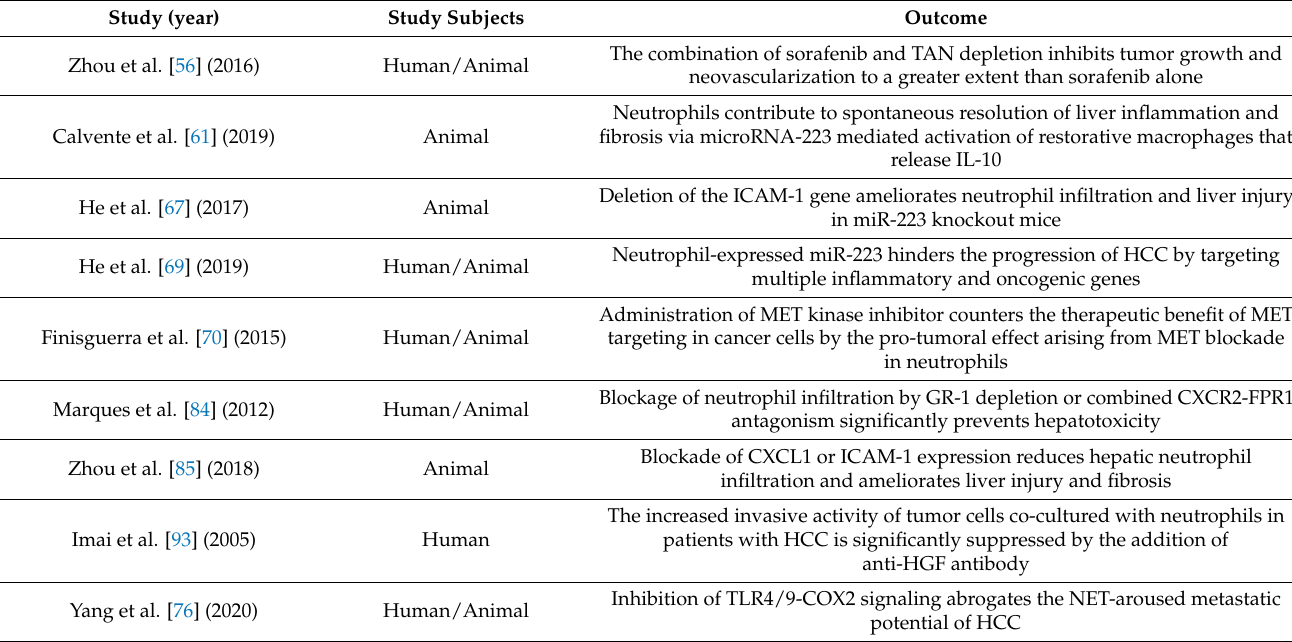
Table 3. Summary of studies evaluating the role of TANs in HCC